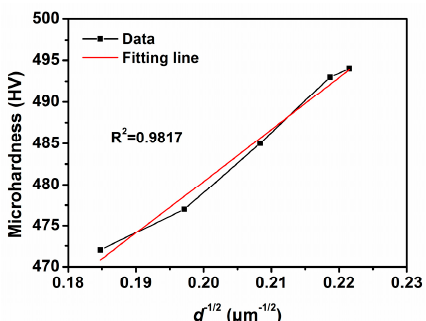
Figure 7. The average microhardness plotted as a function of the average grain sizes of the prepared coating specimens.